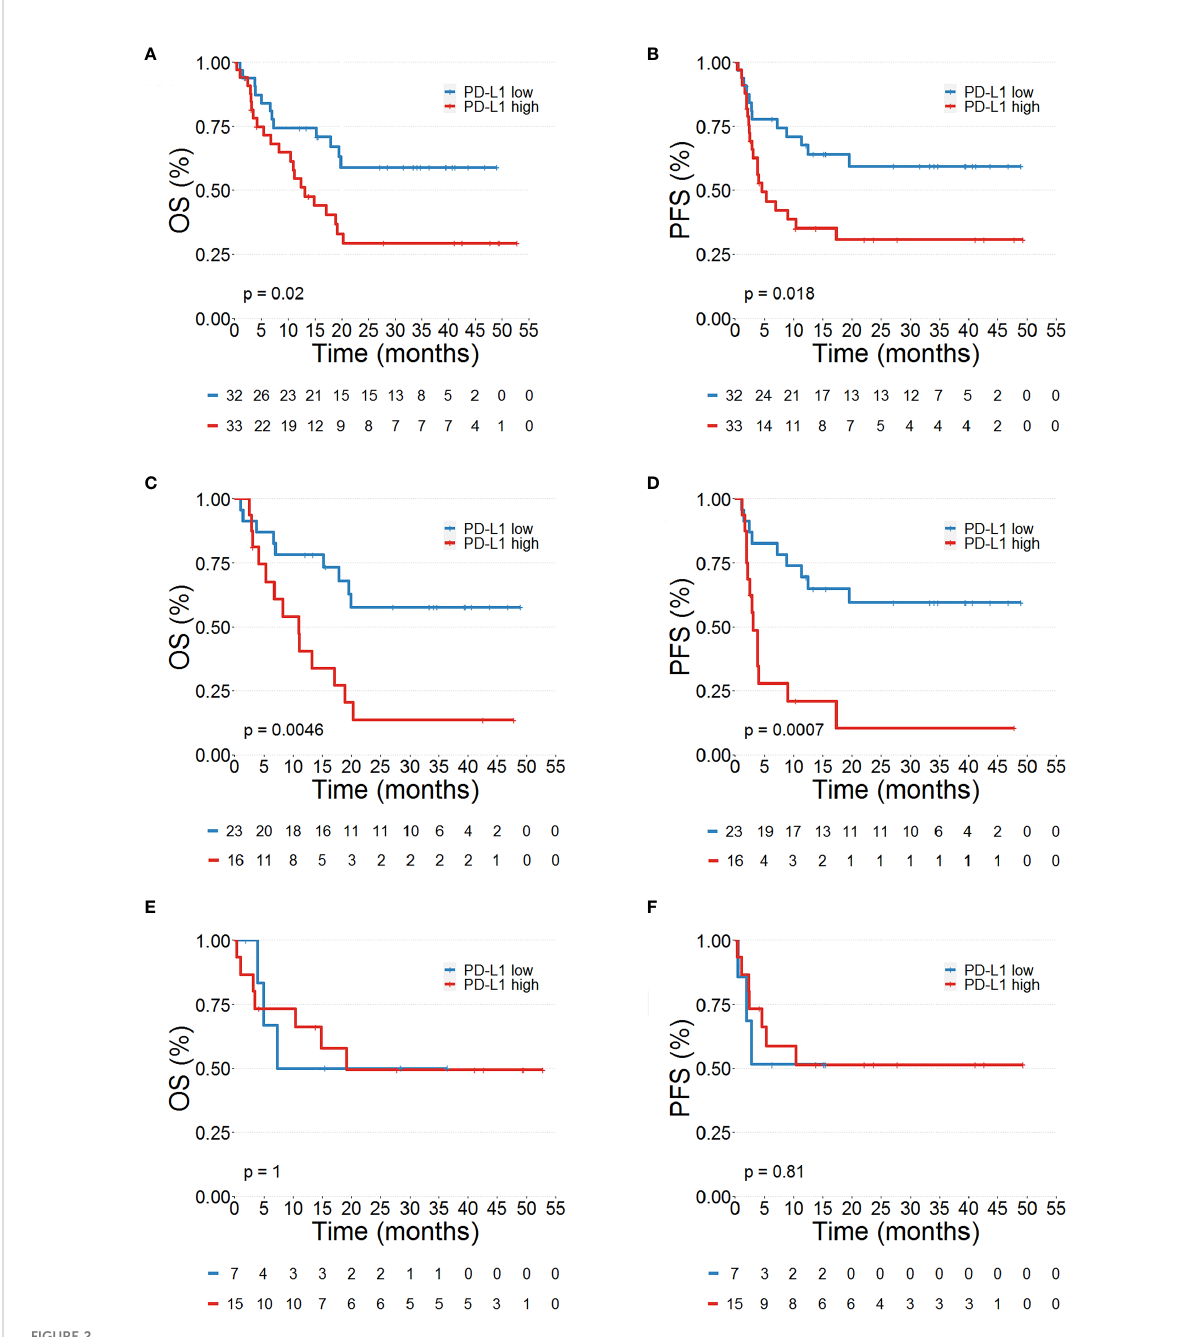
FIGURE 2 Prognostic signi fi cance of PD-L1 + neutrophils in advanced melanoma patients. Kaplan – Meier survival curves show overall survival (OS %) (A, C, E) and progression-free survival (PFS %) (B, D, F) for advanced melanoma patients presenting a high (red line) or low (blue line) PD-L1 + PMNs in the whole patient cohort (A, B) , in BRAF wild-type (C, D) and BRAF mutated (E, F) melanoma patients. Low and high PD-L1 + values were calculated using the median as the